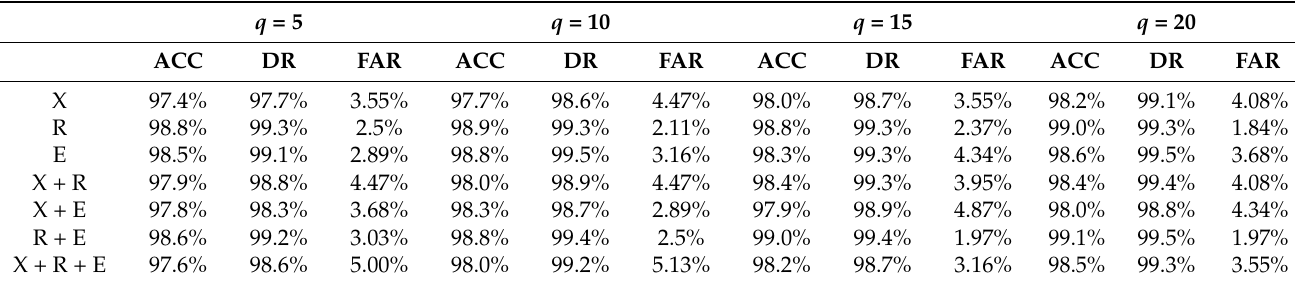
Table 8. Results of binary classification with different CaForest